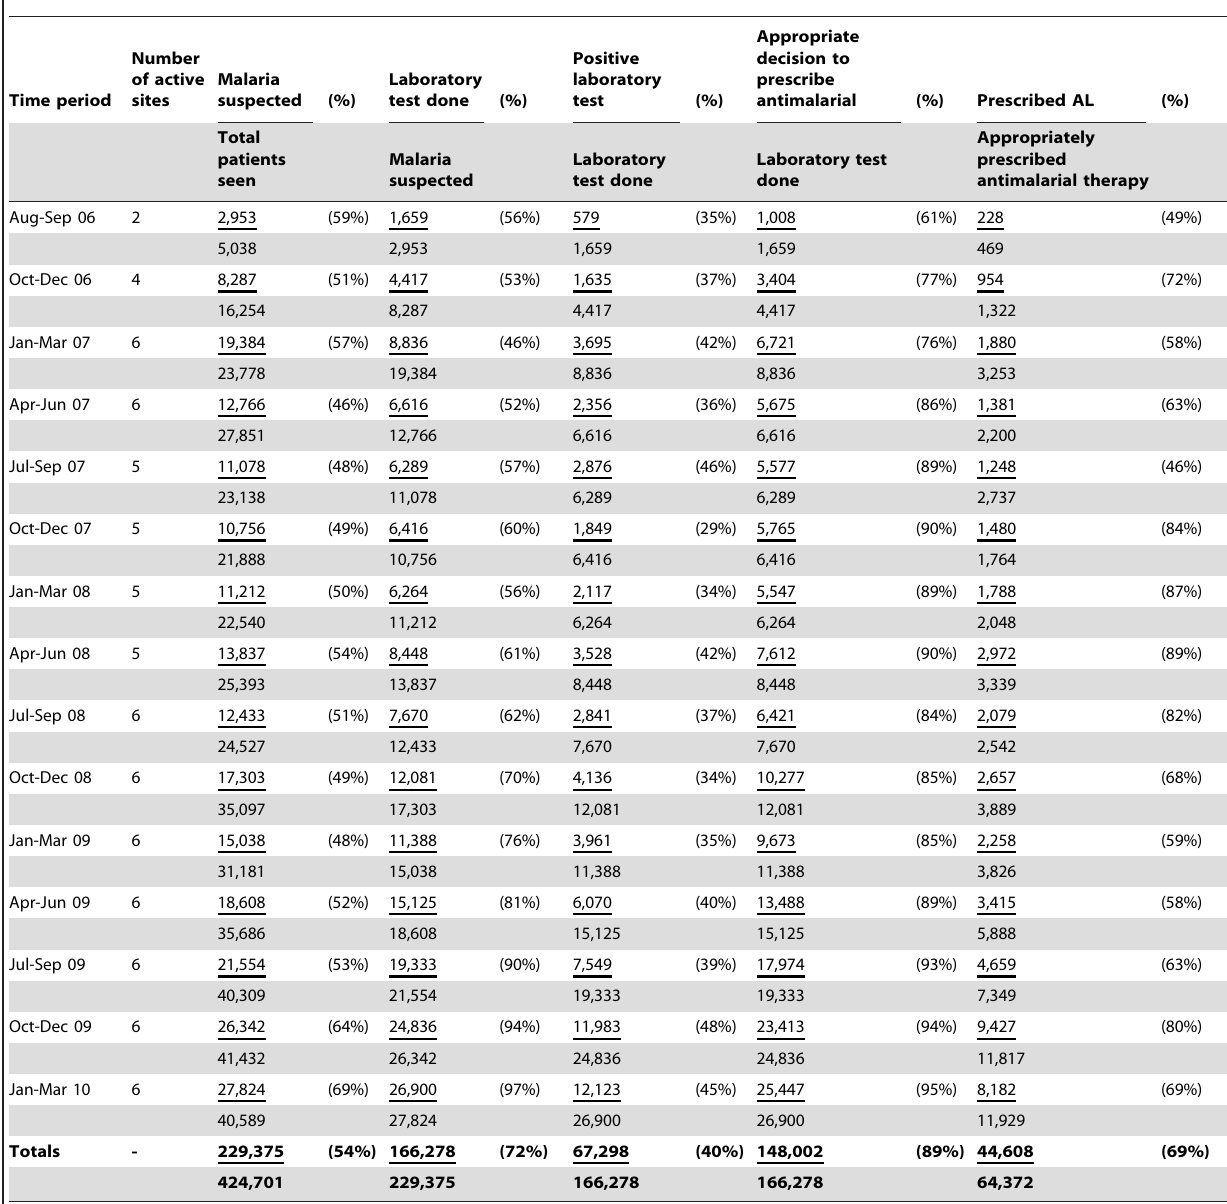
Table 1. Absolute numbers and proportions for key steps in malaria case management algorithm (all sites